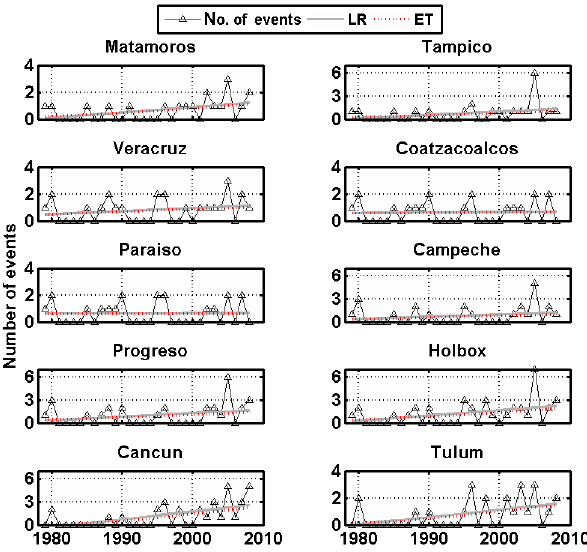
Figure 6. Time series of the number of events caused by TCs each season and trends shown as simple linear regressions (LRs) and as the estimated trend (ET) obtained from the log-transformed data and the probability of storm occurrence, ˆ M s (t) . The slopes of the regression lines are given in Table 3. Notice the different vertical scale used for on each